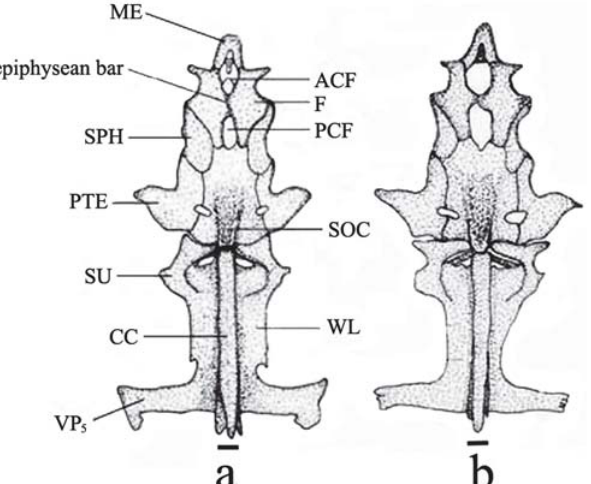
Fig. 2. Dorsal view of neurocranium and Weberian complex of ( a ) Bunocephalus erondinae , paratype, MCP 8966 (71.6 mm SL) and of ( b ) B . doriae , MCP 13176 (50.9 mm SL). ACF, anterior cranial fontanel; CC, complex centrum; F, frontal; ME, mesethmoid; PCF, posterior cranial fontanel; PTE, pterotic; SOC, supraoccipital; SPH, sphenotic; SU, supracleithrum; VP parapophysis 5; and WL, Weberian lamina. Scale bar = 1 mm.